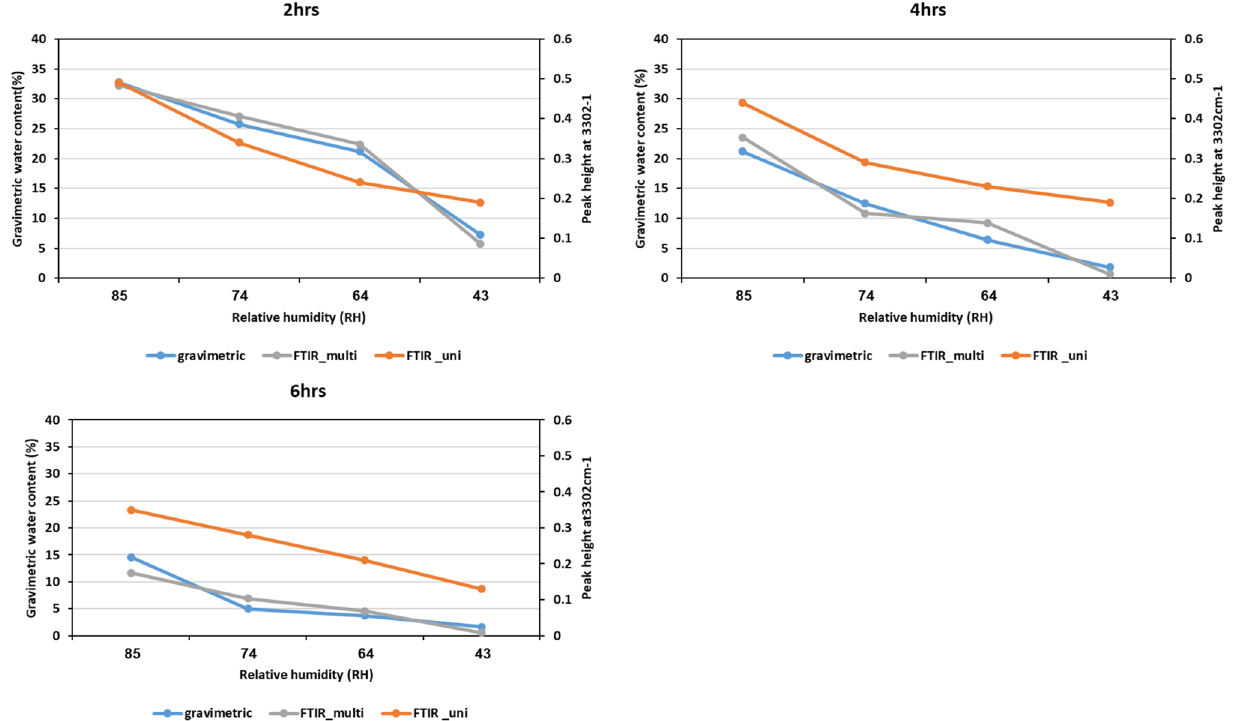
Figure 5. Comparison of water content in rapidly desiccated S. carpocapsae at 85, 74, 64 and 43%RH arising from Gravimetric measurements, FTIR univariate and predicted by FTIR multivariate method using PLS-R. The correlation coefficient (R 2 ) of FTIR multivariate to gravimetric measurements was